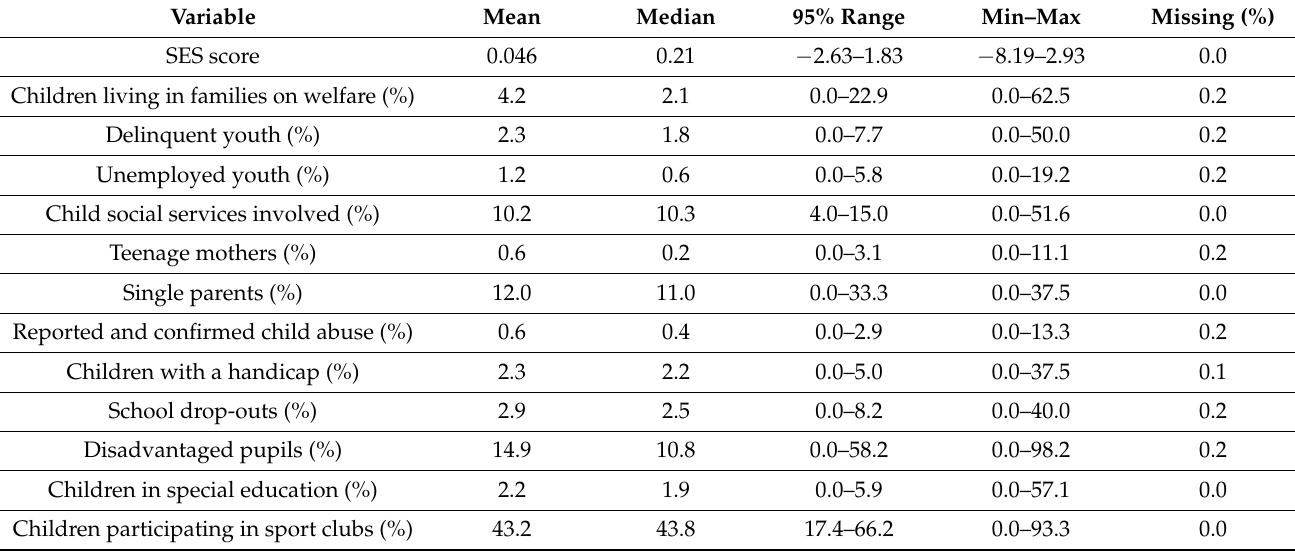
Table 2. Characteristics of social indicators of child